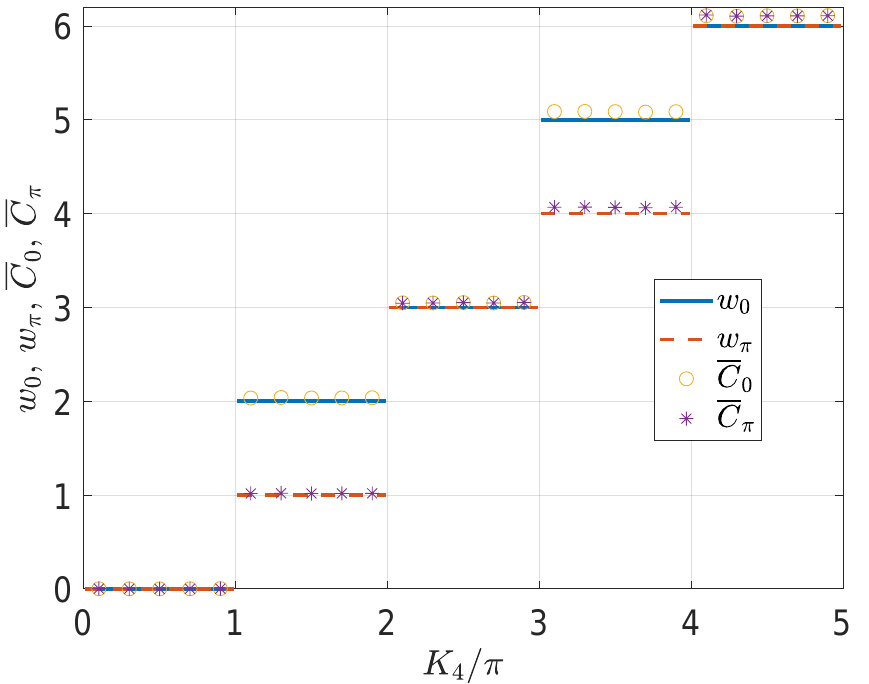
Figure 3. Topological invariants ( w 0 , w π ) and time-averaged mean chiral displacements ( C 0 , C π ) of the 2D on-resonance double-kicked lattice versus the kicking strength K 4 . The other system parameters are set as K 1 = 0.5 π , K 2 = 3.5 π and K 3 = 0.5 π . The mean chiral displacements are averaged over t = 50 driving periods to generate the results for ( C 0 , C π )